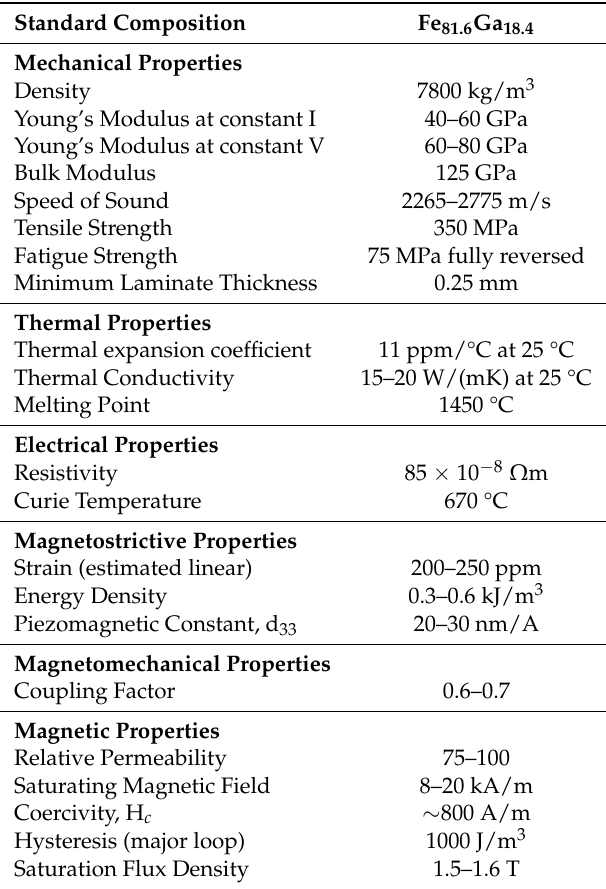
Table 1. Some properties of Galfenol